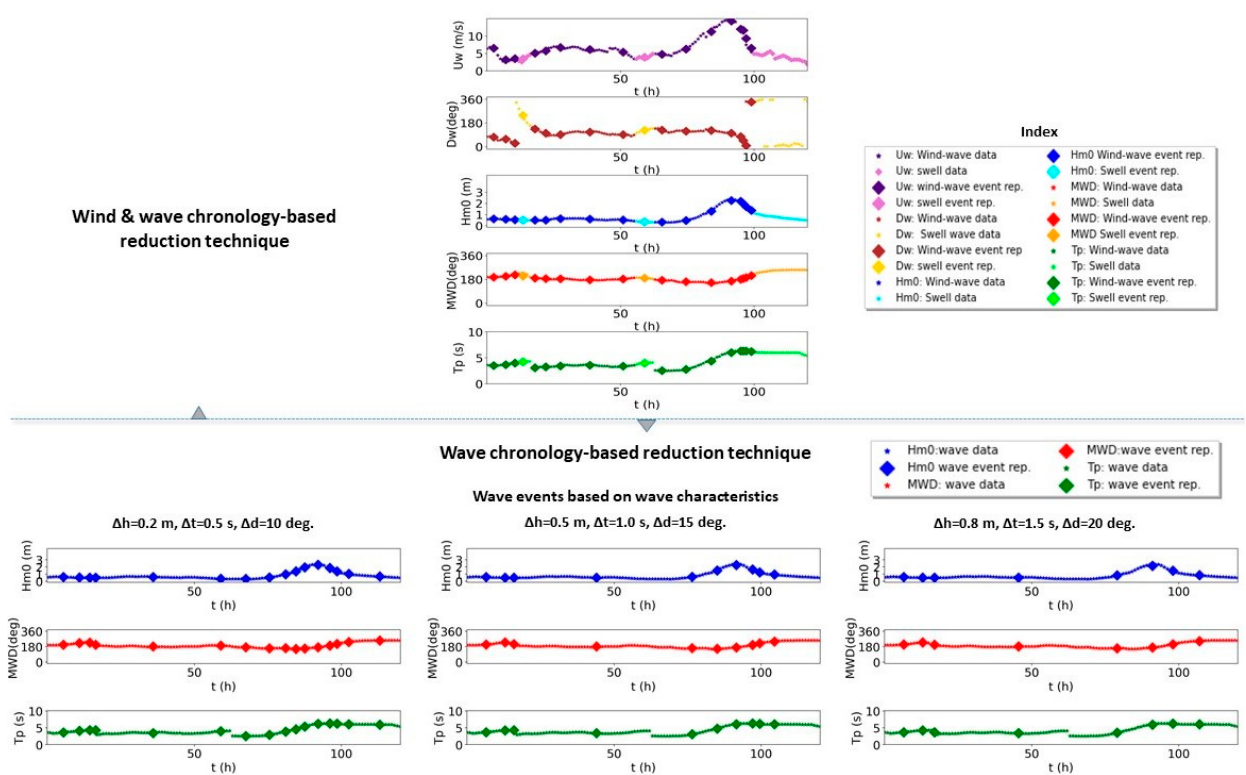
Figure 6. The extraction of wave events time series from an indicative subset of data by the wind and wave chronology-based reduction technique ( up ) and the wave chronology-based reduction techniques ( below ) using different values for 𝛥ℎ , 𝛥𝑡 , and 𝛥𝑑 .